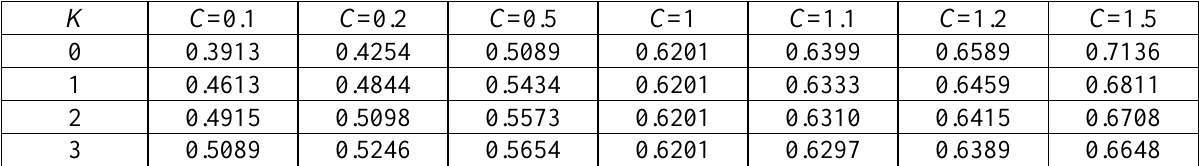
¢- with C and K ( Pr =0.7, B